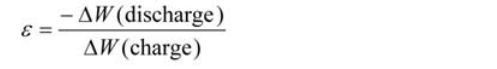
Figure 1. Comparison of a series of galvanostatic cycles measured on different cells at different current densities: a) LiMnPO 16C in the potential window 2.7–4.5 V vs. Li), b) LiFePO C/10 up to 5C in the potential window 3.0–4.25 V vs. Li). In all the cases the third cycle measured at certain C-rate is plotted; all the curves were measured at 25 °C and obtained using the conventional constant-current “CC” cycling